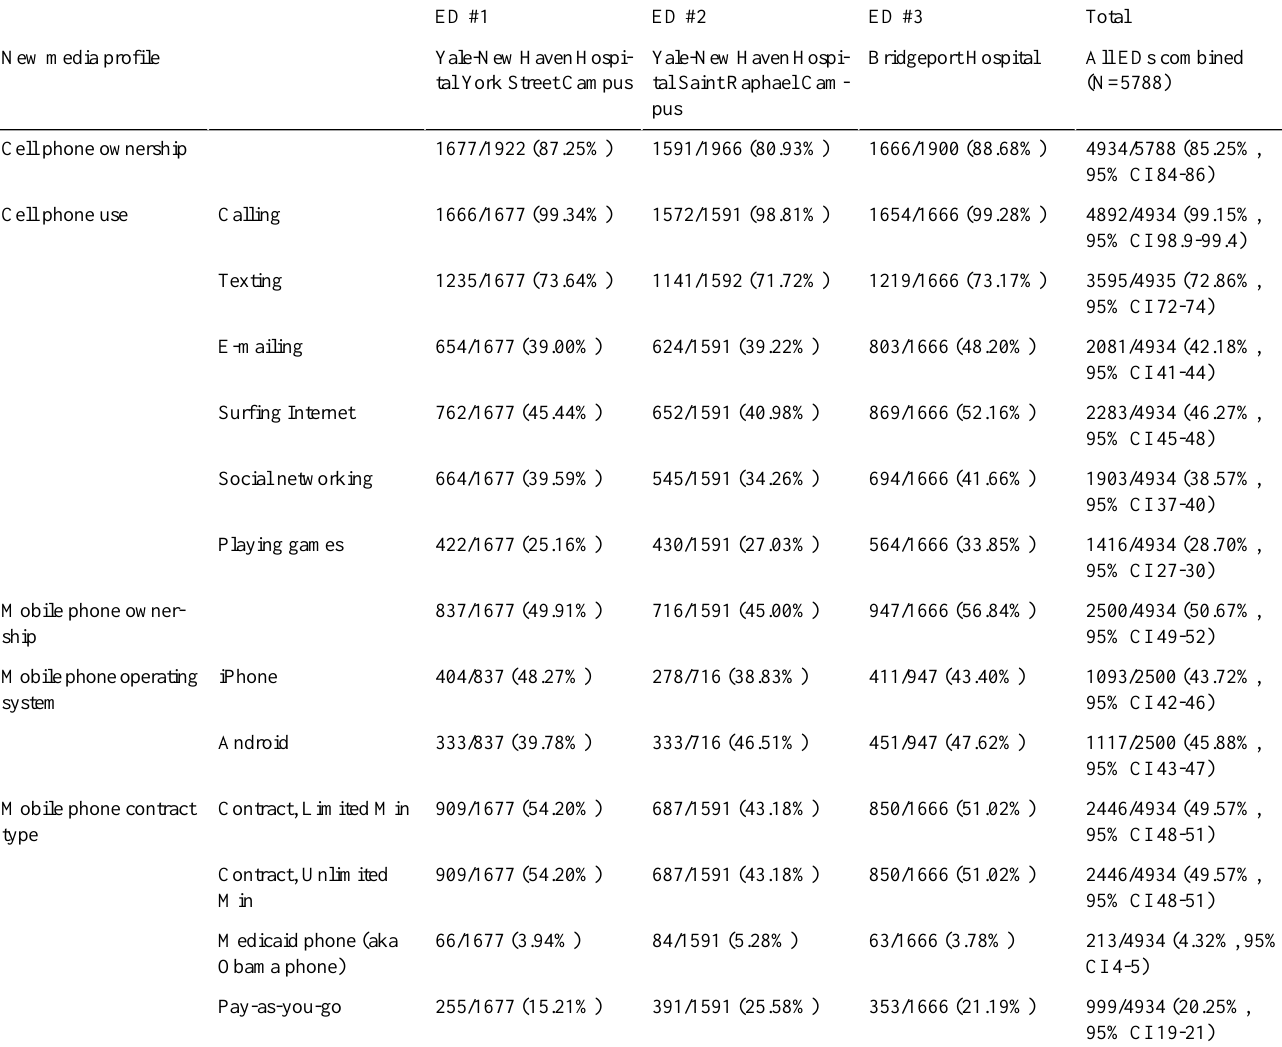
Table 2. New media use prevalence and taxonomies, July 12 to August 30,